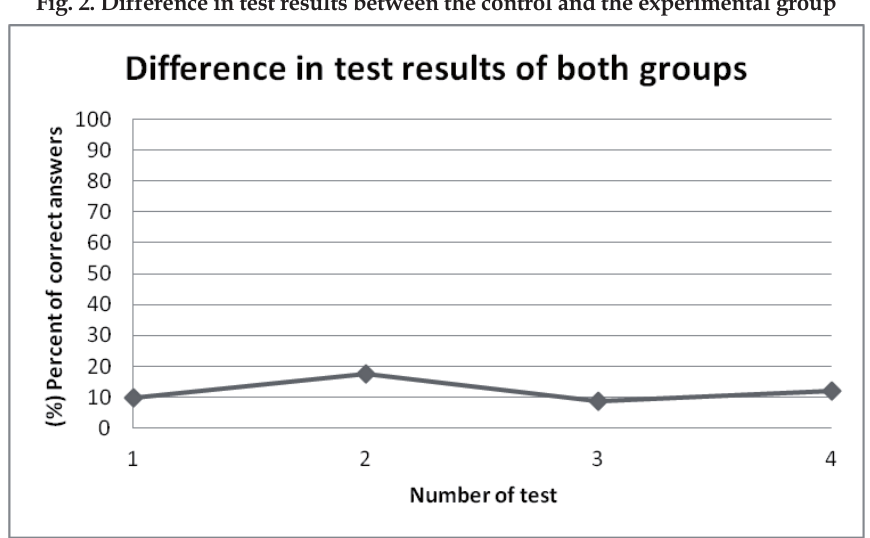
Fig. 2. Difference in test results between the control and the experimental